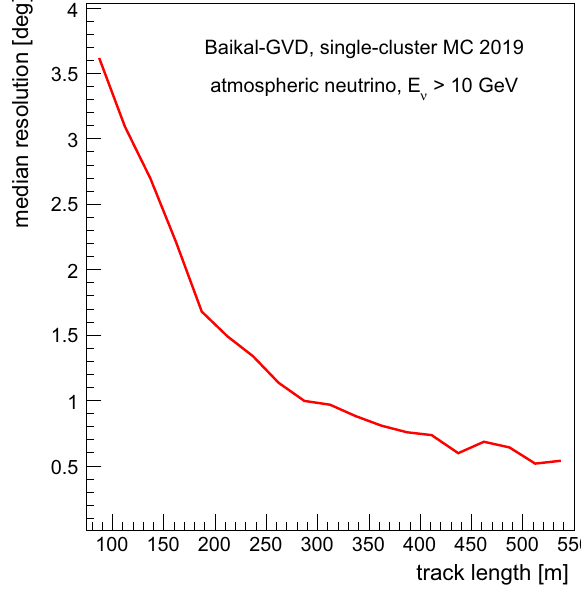
Fig. 6 Angular resolution of the χ 2 -based reconstruction method for muon neutrino observations using a single Baikal-GVD cluster after the event selection cuts, shown as a function of visible track length. Shown are the median resolution values averaged over the atmospheric neutrino spectrum and zenith angle range θ > 120 ◦ . A 5 ns calibration accuracy is assumed